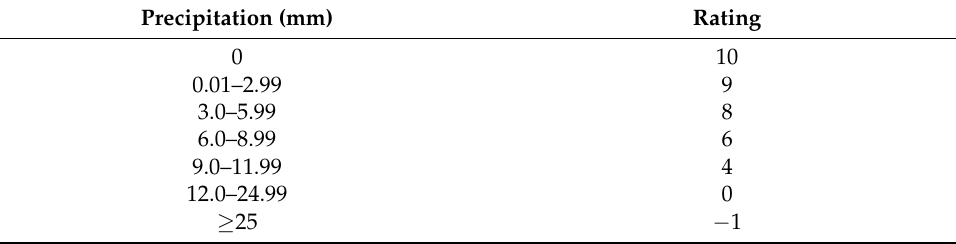
Table A5. Physical facet rating values